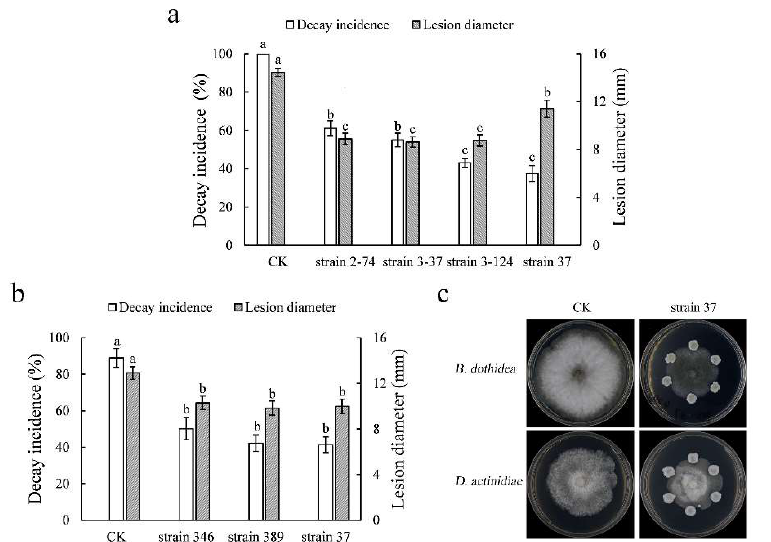
Figure 1. Inhibitory impact of selected candidate yeast strains on the soft rot of kiwifruit caused by Botryosphaeria dothidea ( a ) and Diaporthe actinidiae ( b ) in vivo and in vitro ( c ). The data is represented as mean ± standard error (SE). The letters above the columns show statistically significant differences ( p < 0.05) as assessed with Duncan’s multiple range test.